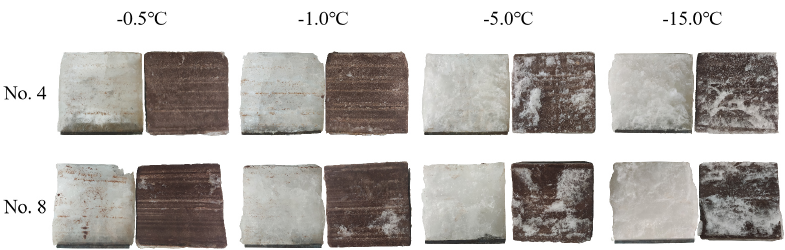
Figure 22. Shear failure characteristics of ice–rock interfaces under different temperatures. Experimental conditions: v = 0.2mmmin − 1 and σ n = 0.5MPa.